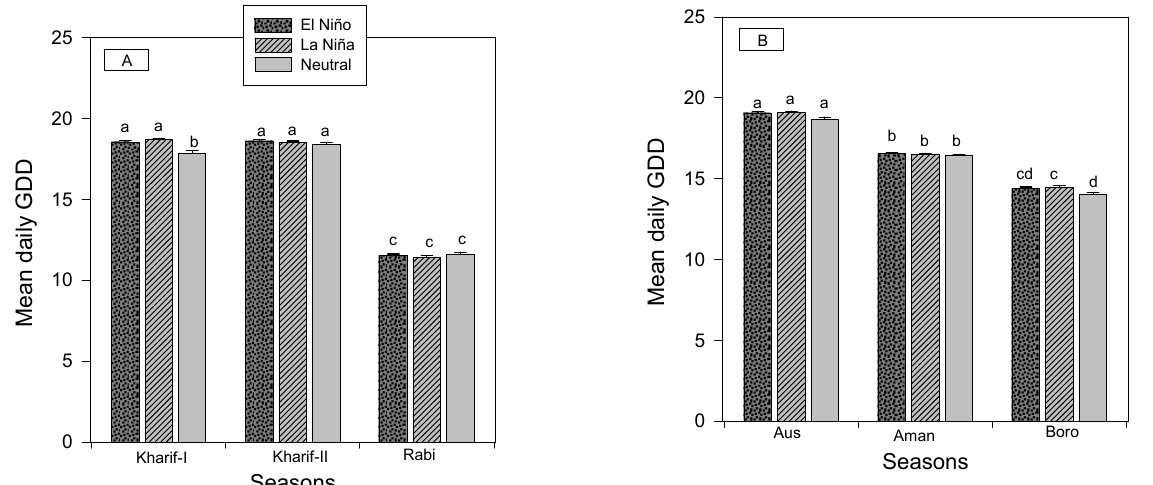
Figure 6. Mean daily GDD of different ENSO events under agricultural ( A ) and rice growing ( B ) seasons. The error margin in the bars represents the standard error of the means while different latter above the bars indicate significant differences (Tukey’s b, α = 5%).